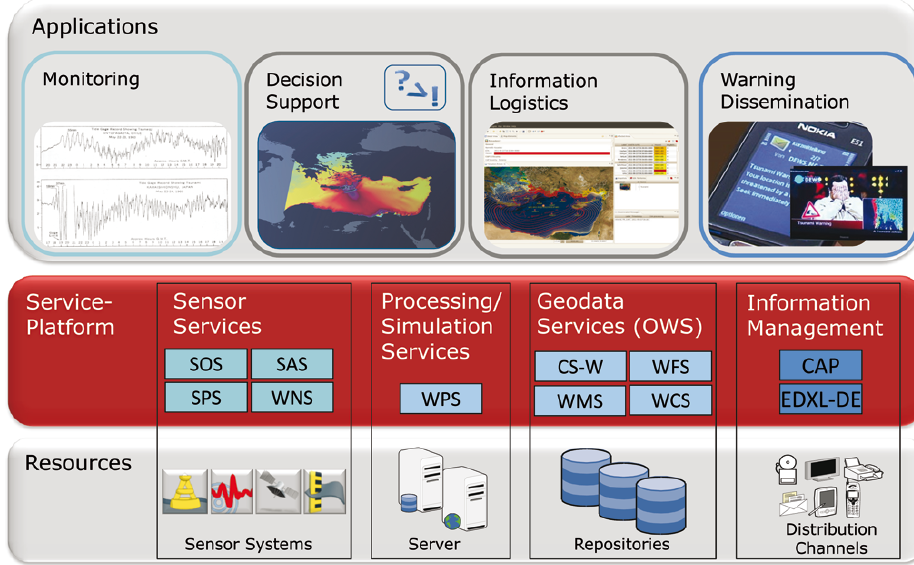
Fig. 2. Schematic architecture of multi-sensor warning systems. The access to computing services, sensor systems, repositories, and distri- bution channels is realised via standardised